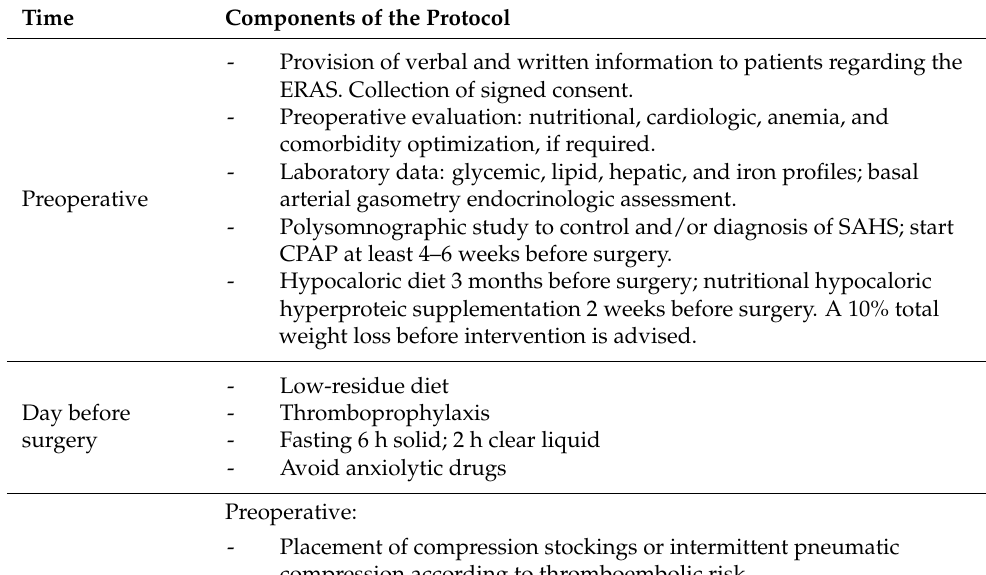
Table 1. Spanish National ERAS protocol for bariatric surgery